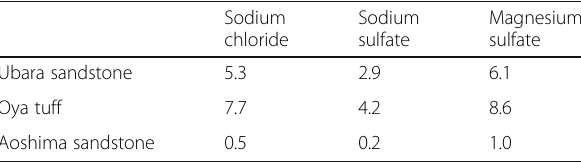
Table 2 Salt content of rock specimens used in the humidity- change experiment